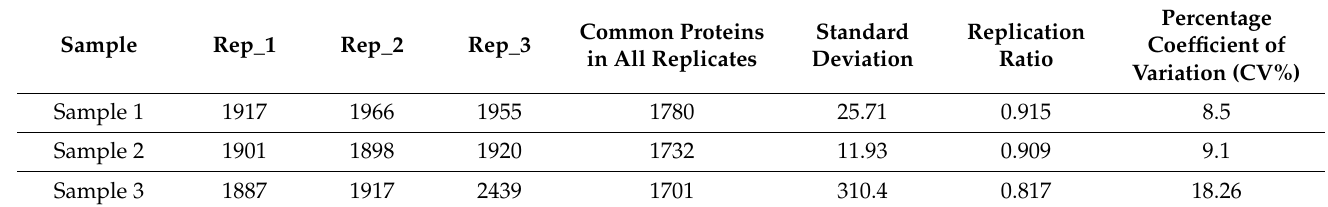
Table 1. Total number of proteins in each sample along with their replication ratio, coefficient of variation percentage, and standard deviation.